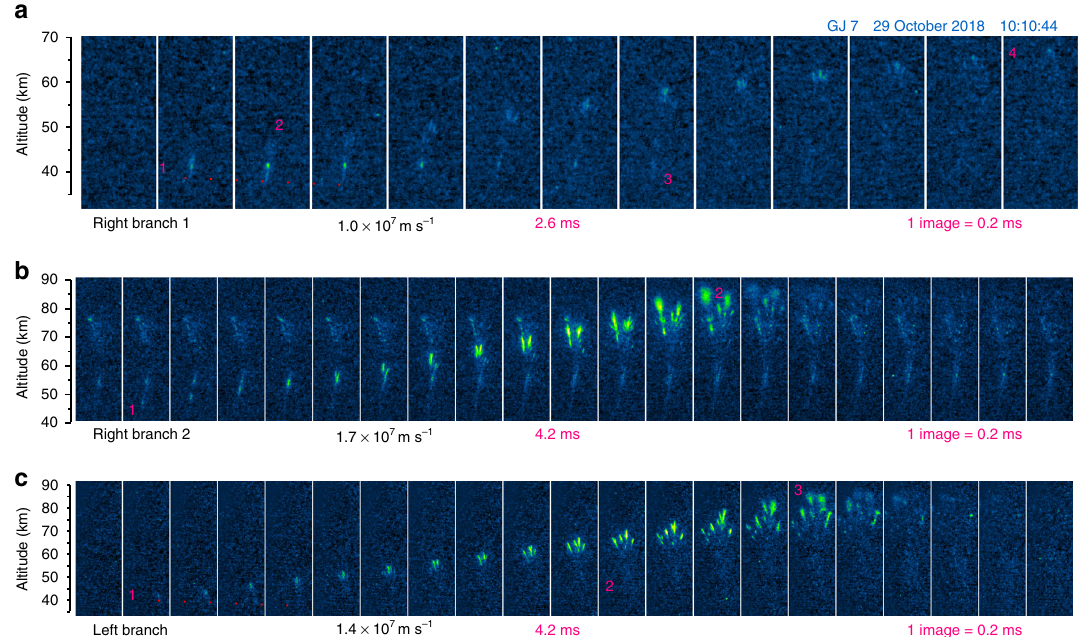
Fig. 3 Development of the three branches of gigantic jet 7 recorded by the high speed camera. Image sequences recorded at 0.2 ms intervals, showing the upward speed of the development, and their brief downward extending parts indicated by a dotted line. a the fi rst right-hand branch, with a clear bidirectional onset, b the second right-hand branch, overlapping visually with remnants of the fi rst, c the third branch, occurring to the left of the others, with a subtle downward